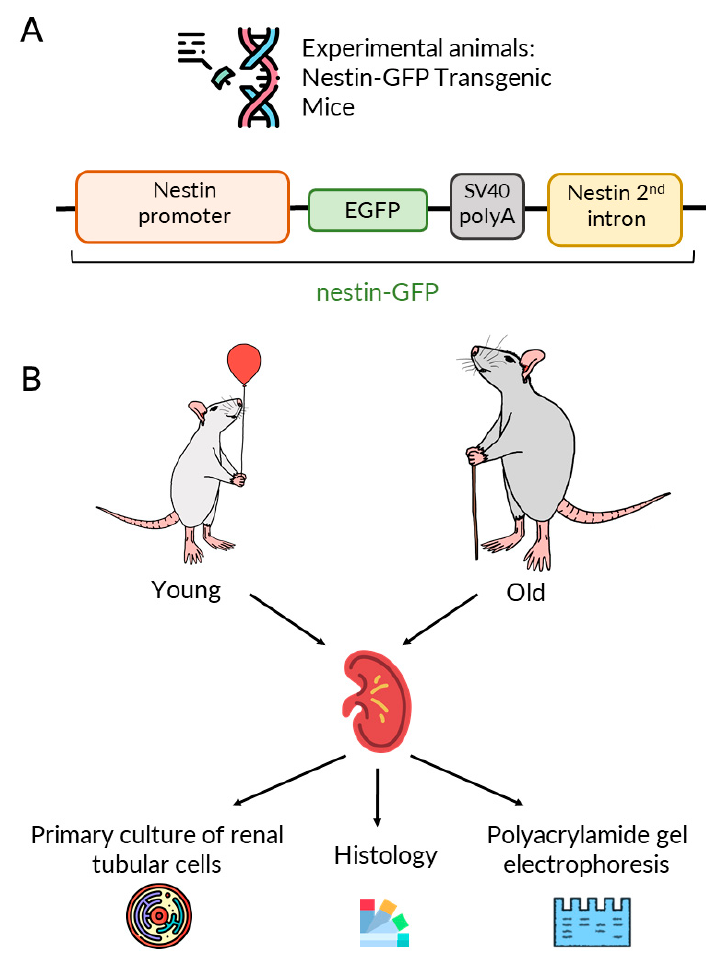
Figure 1. Experimental design. ( A ) Scheme of the nestin-GFP construct of transgenic nestin-GFP mice. For the details see [13]. ( B ) The experimental design of our study.